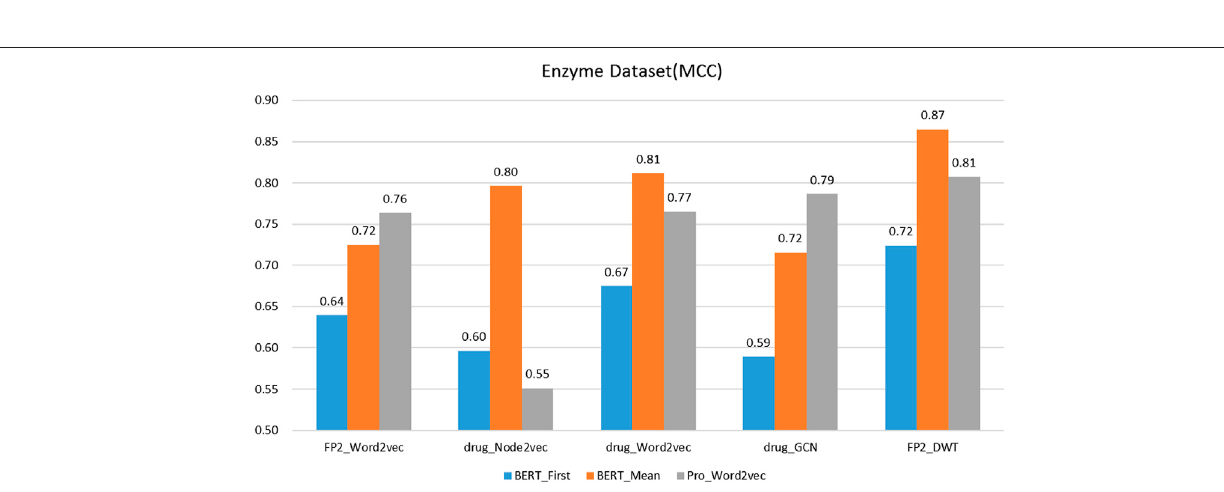
FIGURE 5 | The performance of different protein and drug descriptors on the enzyme